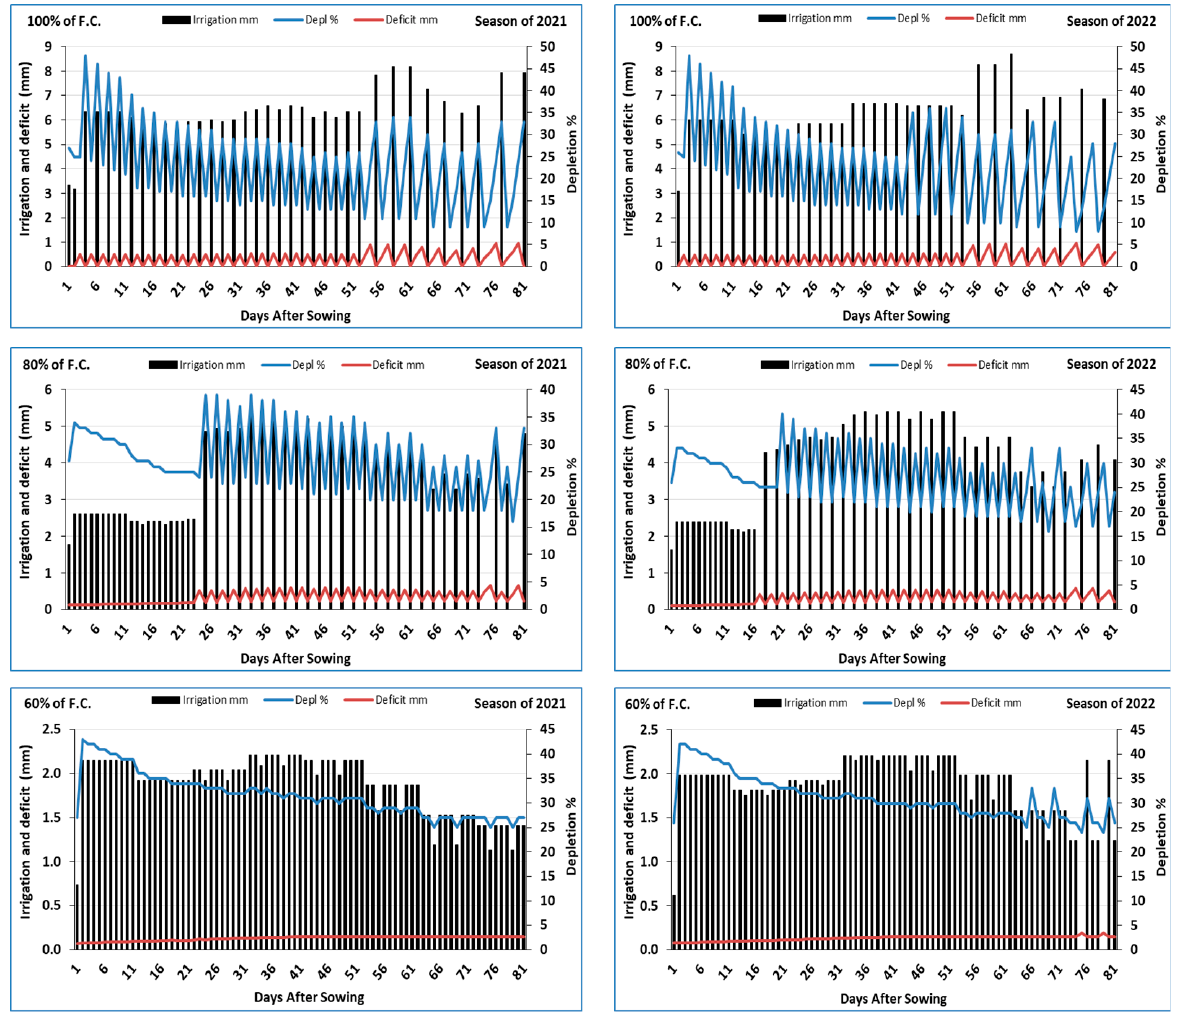
Figure 3. The depletion (%), deficit (mm), and irrigation (mm) under 100, 80, and 60% of field capacity (FC) for the 2021 and 2022 growing seasons.